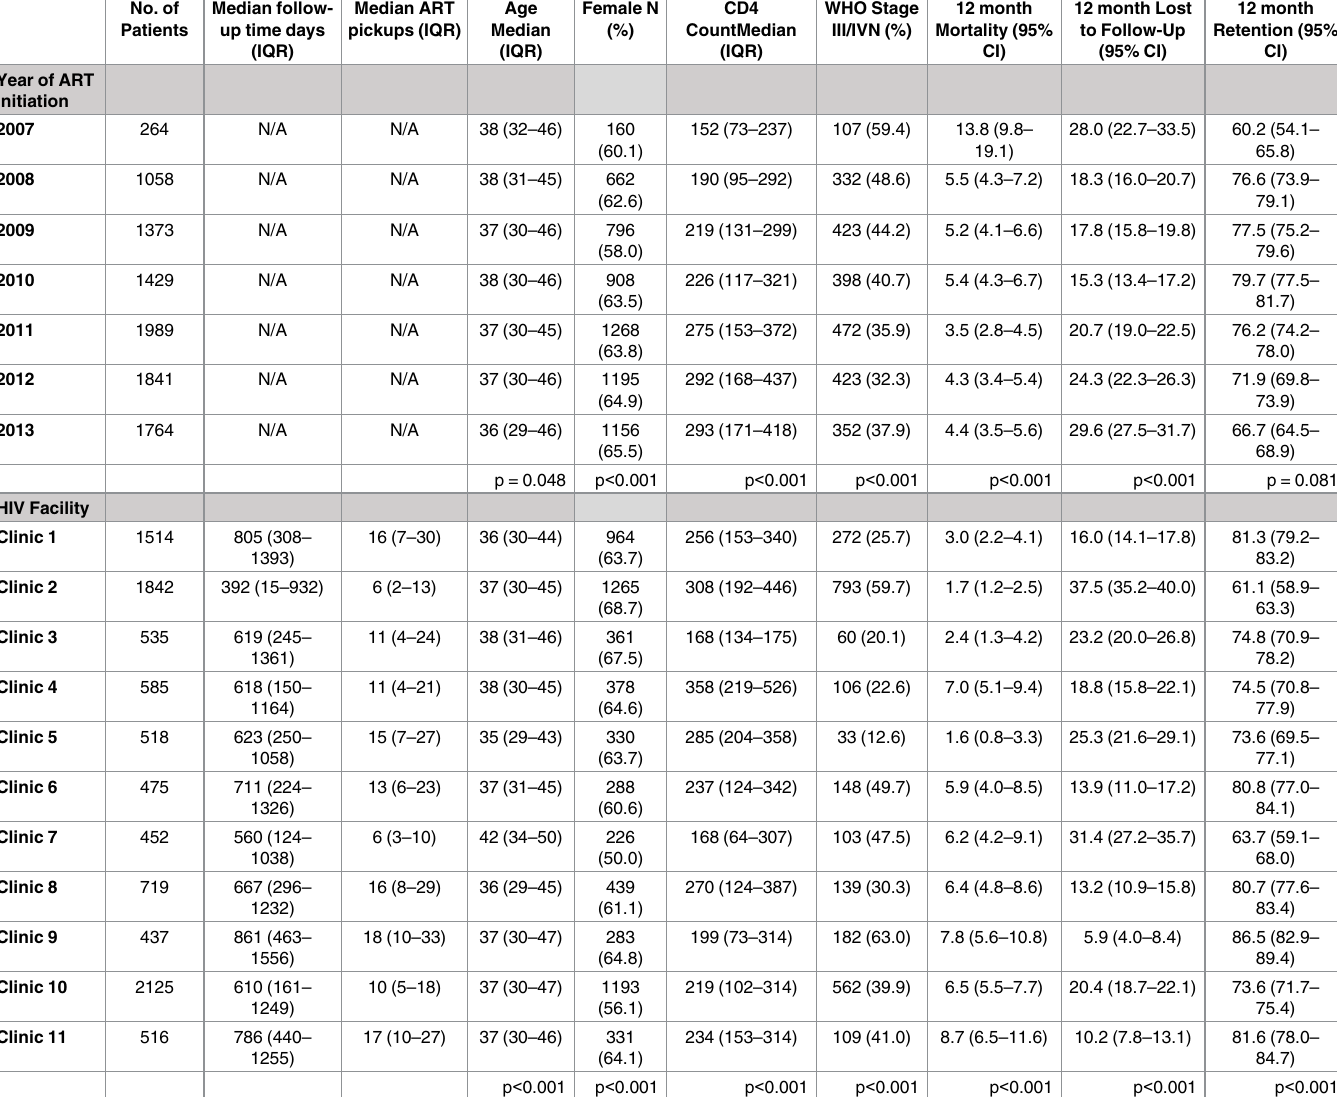
Table 2. Patient characteristics and outcomes of adults initiating antiretroviral therapy by calendar year of initiation and by HIV facility. No. of Median follow- Patients up time